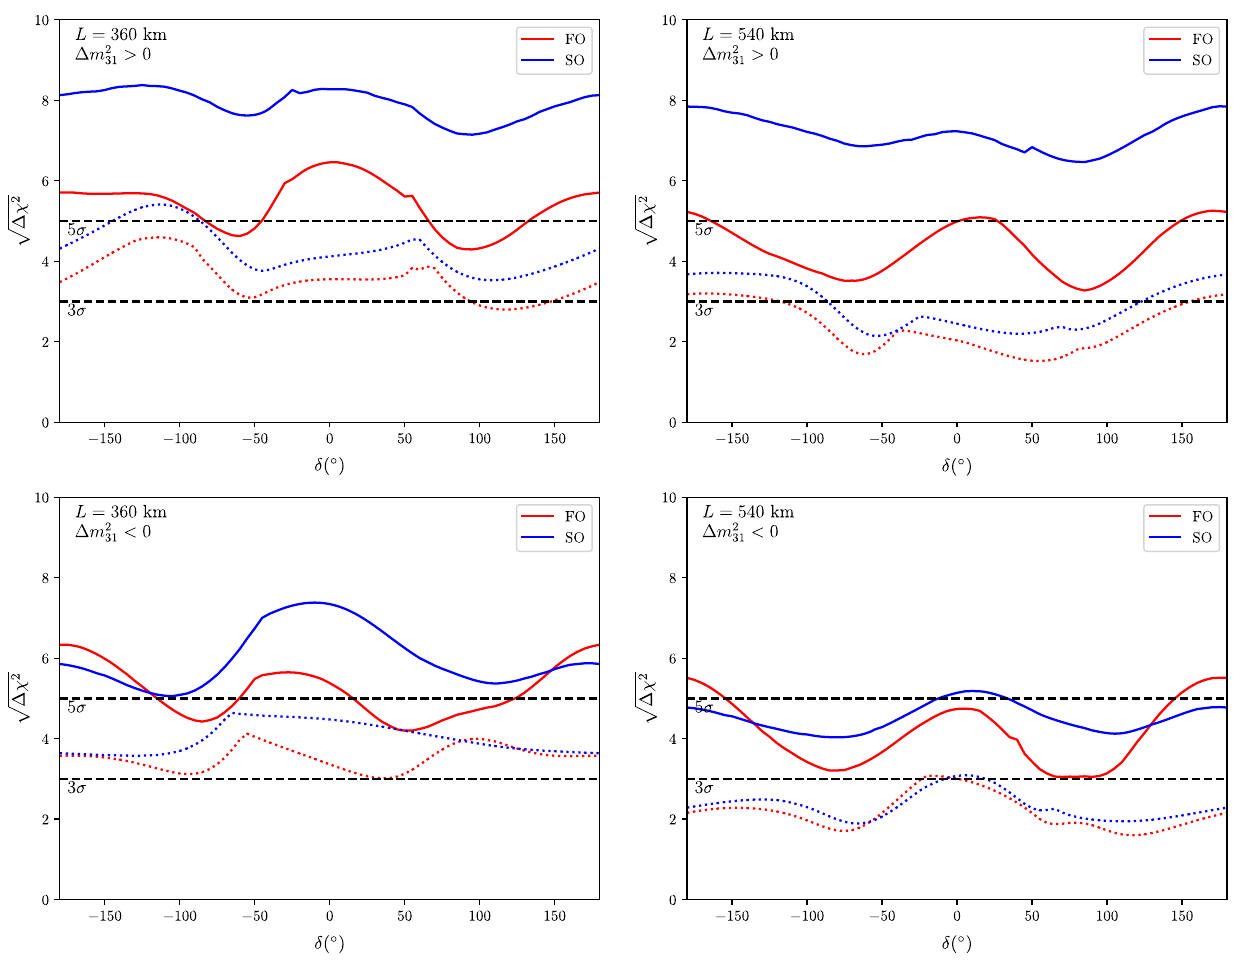
Fig. 7 Significance with which the wrong mass ordering would be dis- favouredfor θ 23 inthefirstoctant(redlines)orsecondoctant(bluelines) andthetruemassorderingbeingnormal(upperplots)orinverted(lower plots). Dashed lines correspond to the beam only data while solid lines